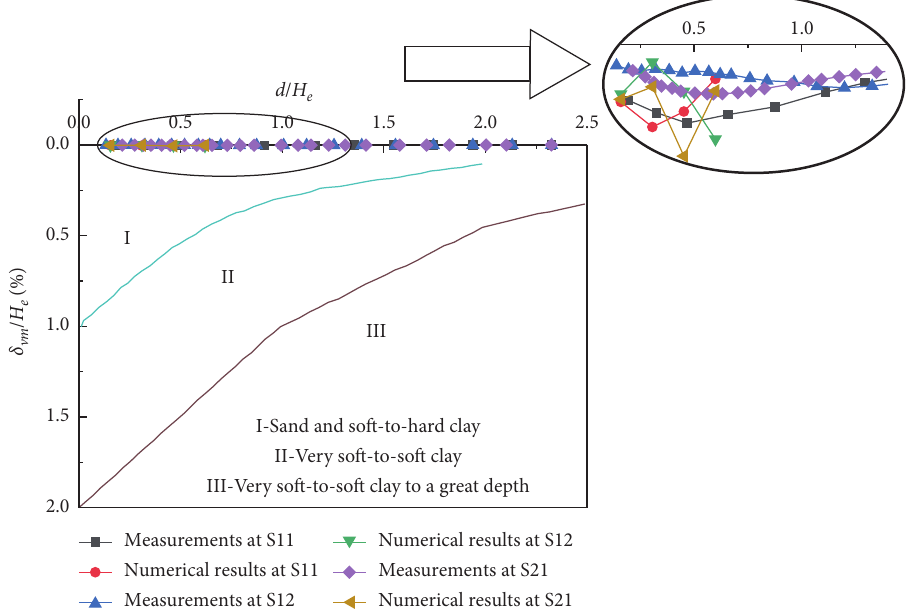
Figure 17: Numerical and measured ground surface settlement with distance behind the wall in Peck’s diagram.